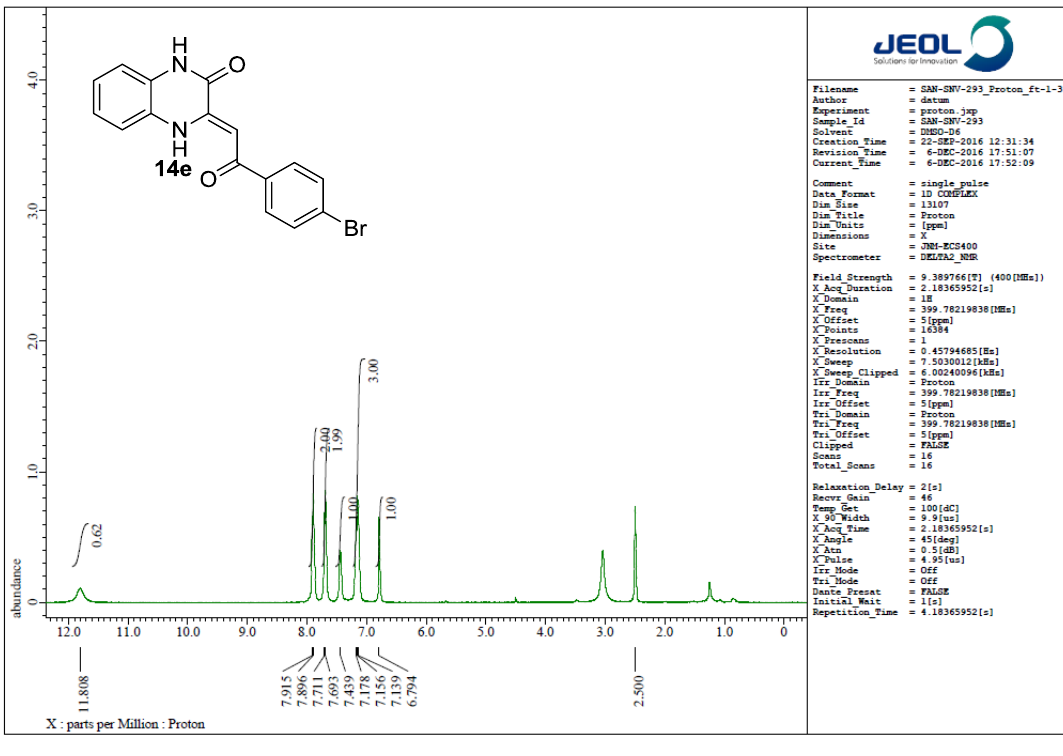
Figure 37 . 1 H NMR Spectra of Compound 14e .